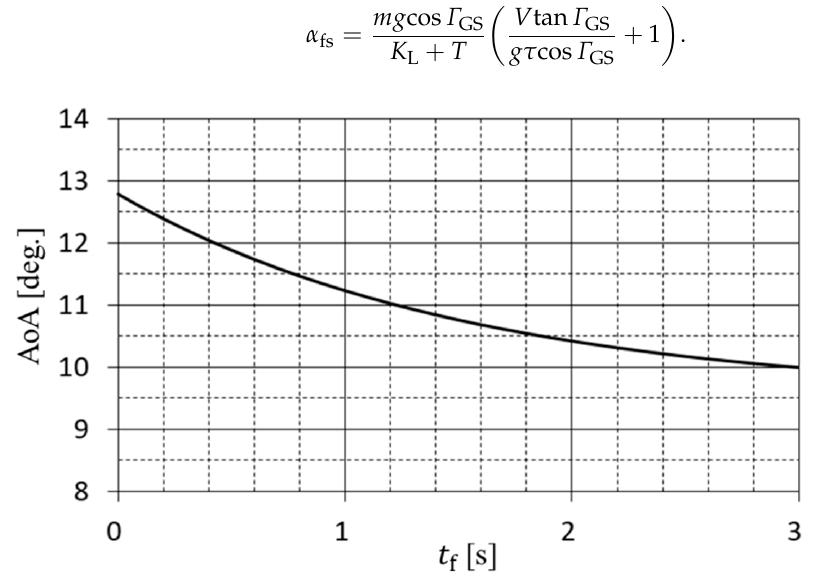
Figure 6. Estimated AoA versus flare time for one-third-scale Oowashi using Equation (19) at τ = 1.5. By calculation, the stall AoA determines the minimum flare time constant τ min , as shown in Equation (21). In the same way as the Γ GSMAX needs to set α MAX , it is necessary to set α MAX to determine τ min . In this term, the tale down angle is